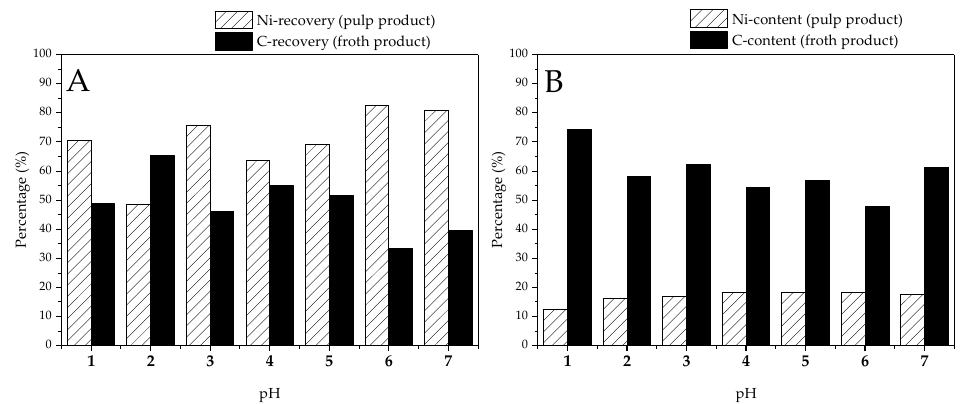
Figure 8. ( A ) Recoveries and ( B ) contents of flotation products obtained from the BM pretreated with F2 solution (0.5 M) at different pH values.